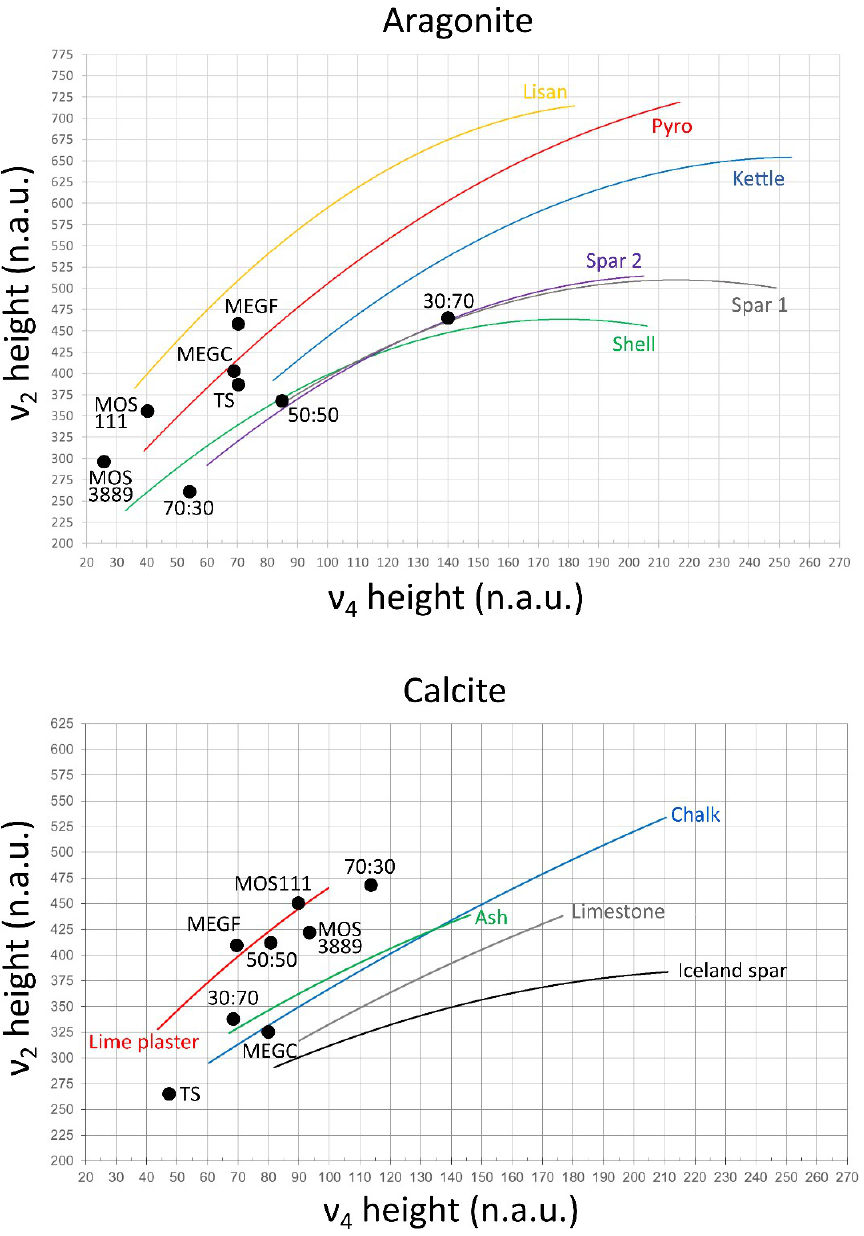
Figure 5. Aragonite and calcite grinding curve plots and location of experimental and archaeological samples (n.a.u.: normalized absorbance units). Calcite plot modified after Regev et al. (2010) [19]. MEGC: Megiddo coarse fraction; MEGF: Megiddo fine fraction; TS: Tell es-Safi/Gath; MOS: Motza. Ratios are calcite:aragonite.